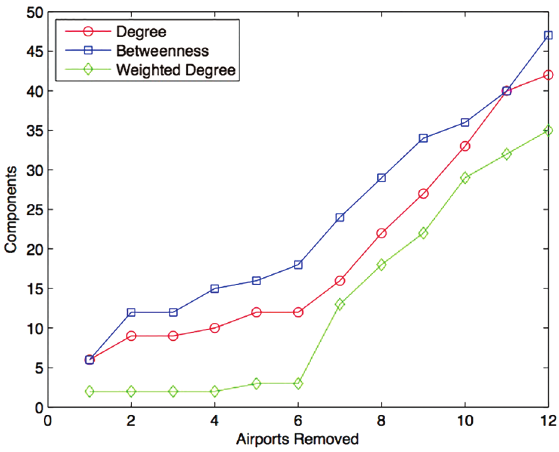
Figure 3 - Changes to the number of components by the total number of removed airports. For interpretation of the references to color in this figure, the reader is referred to the web version of this article.